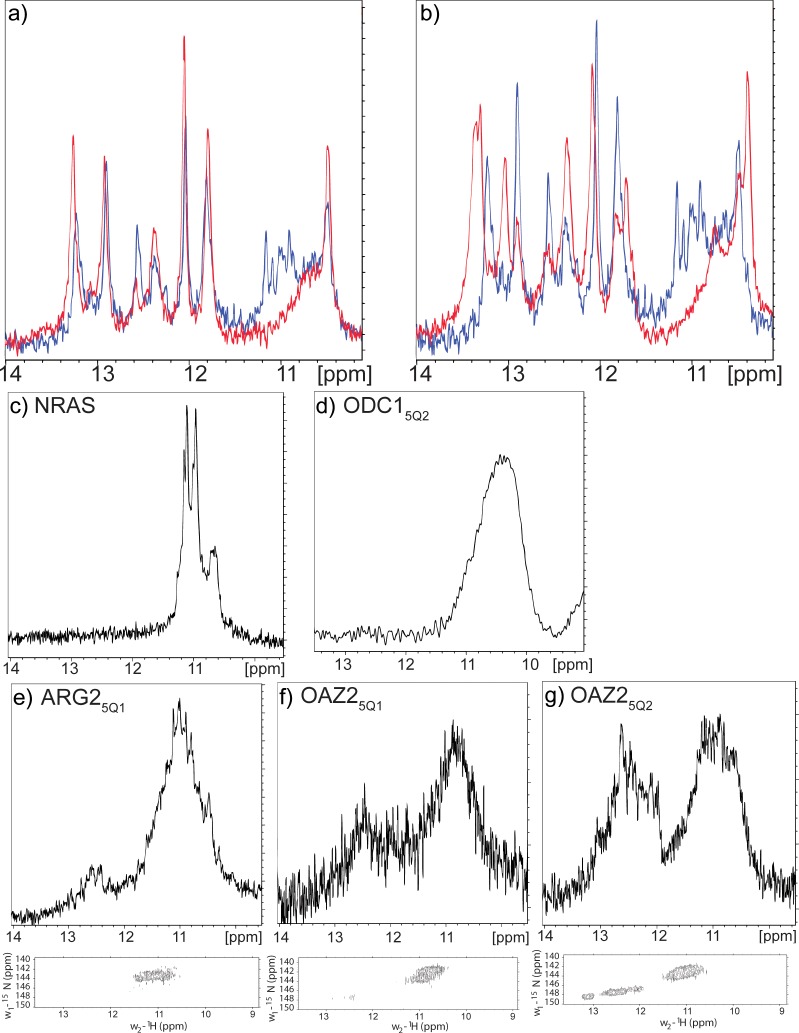
1H NMR spectra of AZIN1wt, NRAS, ODC15Q2, ARG25Q1, OAZ25Q1 and OAZ25Q2.(a) Overlay of 1D 1H NMR spectra corresponding to the imino region of AZINwt in 100 mM KCl (blue) and 100 mM NaCl (red). (b) Overlay of 1D 1H NMR spectra corresponding to the imino region of AZINwt in 100 mM KCl (blue) and 2 mM MgCl2 (red). (c-d) 1D 1H NMR spectra corresponding to the imino region of NRAS and ODC15Q2 in 100 mM KCl. (e-g) 1D 1H NMR spectra and 1H-15N HSQC spectra corresponding to the imino region of ARG25Q1, OAZ25Q1 and OAZ25Q2 in 100 mM KCl. The imino protons observed at 11 ppm are bound to nitrogen atom with a chemical shift of about 145 ppm. The imino peaks at 12–13 ppm observed with OAZ25Q2 suggests that this RNA may form two alternative structures (G-quadruplex and a stem), similarly to what is observed with AZIN1wt. AZIN1pos: GGAGGCUUGGUGG; AZIN1neg: AAACCCAGACAUAGGCUUGGUGG; NRAS: GGGAGGGGCGGGUCUGGG; (0.03–0.5 mM RNA).